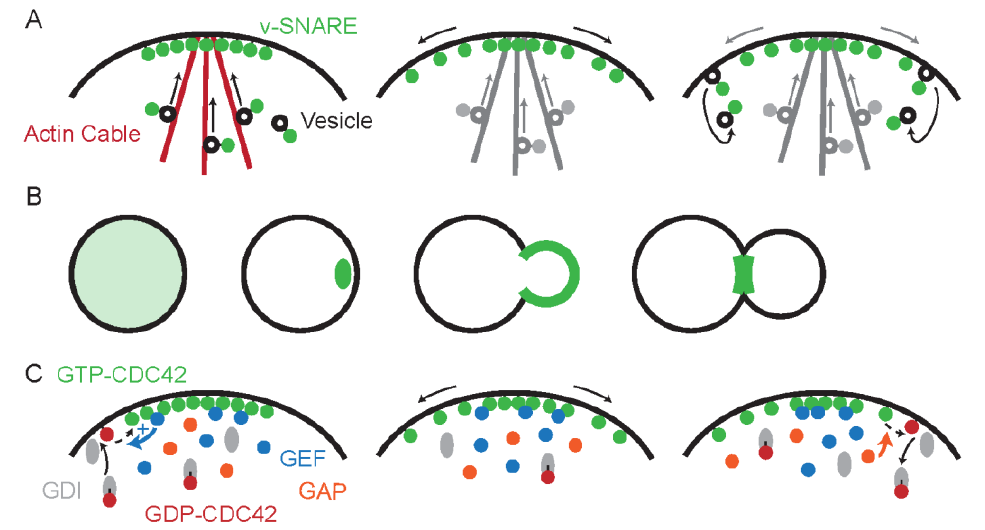
Figure 2. Dynamic localization of integral membrane and peripheral membrane proteins. ( A ) Asymmetric distribution of v-SNAREs arises from vesicle-mediated delivery of v-SNAREs to polarity sites (left), slow diffusion of v-SNAREs on the membrane (middle), and recycling via endocytosis (right). Note that while these processes are highlighted in separate panels for clarity, they all occur continuously. ( B ) Cdc42 localization through the cell cycle. ( C ) Asymmetric distribution of GTP-Cdc42 arises from deposition of GDP-Cdc42 on the membrane by GDI followed by local activation by GEF (left), diffusion of GTP-Cdc42 on the membrane (middle), and inactivation by GAP allowing GDI to pluck GDP-Cdc42 off the membrane, recycling it to the cytoplasm (right). Note that while these processes are highlighted in separate panels for clarity, they all occur continuously. Recruitment of GEF to sites with GTP-Cdc42 enables a positive feedback loop that loads GTP on neighboring Cdc42.